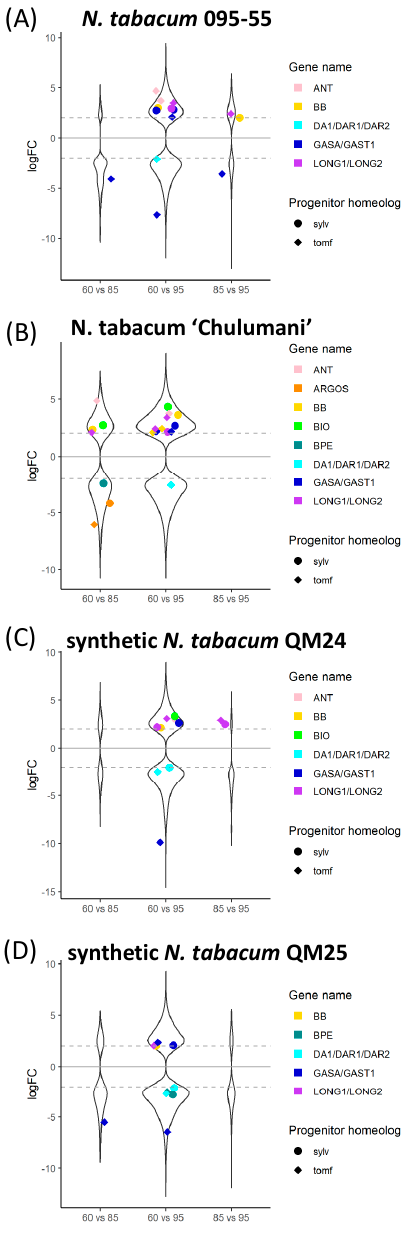
Figure 5. Log 2 fold change of di ff erentially expressed genes across comparisons within accessions between 60%, 85%, and 95% developmental time points for ( A ) N. tabacum 095-55, ( B ) N. tabacum ‘Chulumani’, ( C ) synthetic N. tabacum QM24, and ( D ) synthetic N. tabacum QM25: violin plots represent all di ff erentially expressed genes between each comparison, whereas colorful strip plots represent di ff erentially expressed candidate floral organ size genes. Positive logFC values represent genes upregulated in the first stage listed in the comparison, whereas negative logFC values represent genes upregulated in the second stage listed. The dashed gray lines across the plot denote the log 2 = | 2 | cuto ff for di ff erentially expressed genes. Sylv = N. sylvestris , tomf = N. tomentosiformis